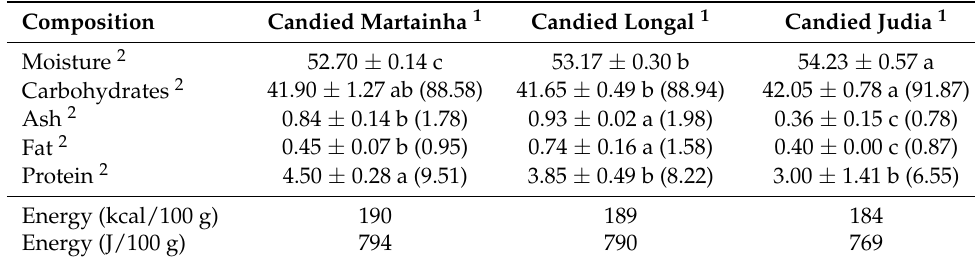
Table 5. Nutritional composition of the candied